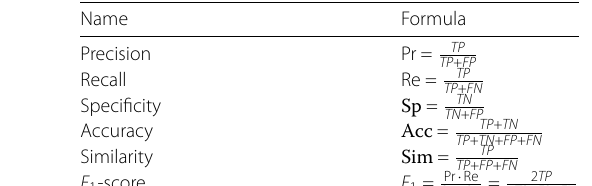
Table 1 Definition of the evaluation metrics